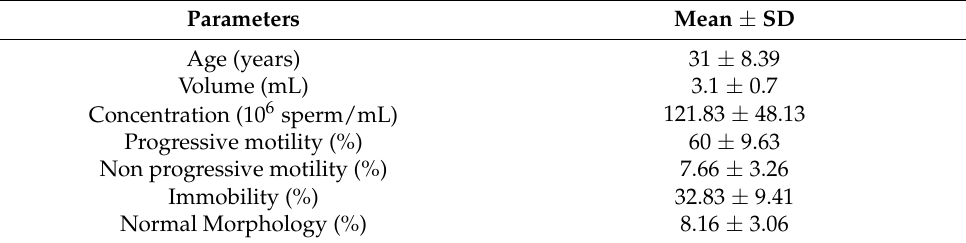
Table 1. Parameters fresh